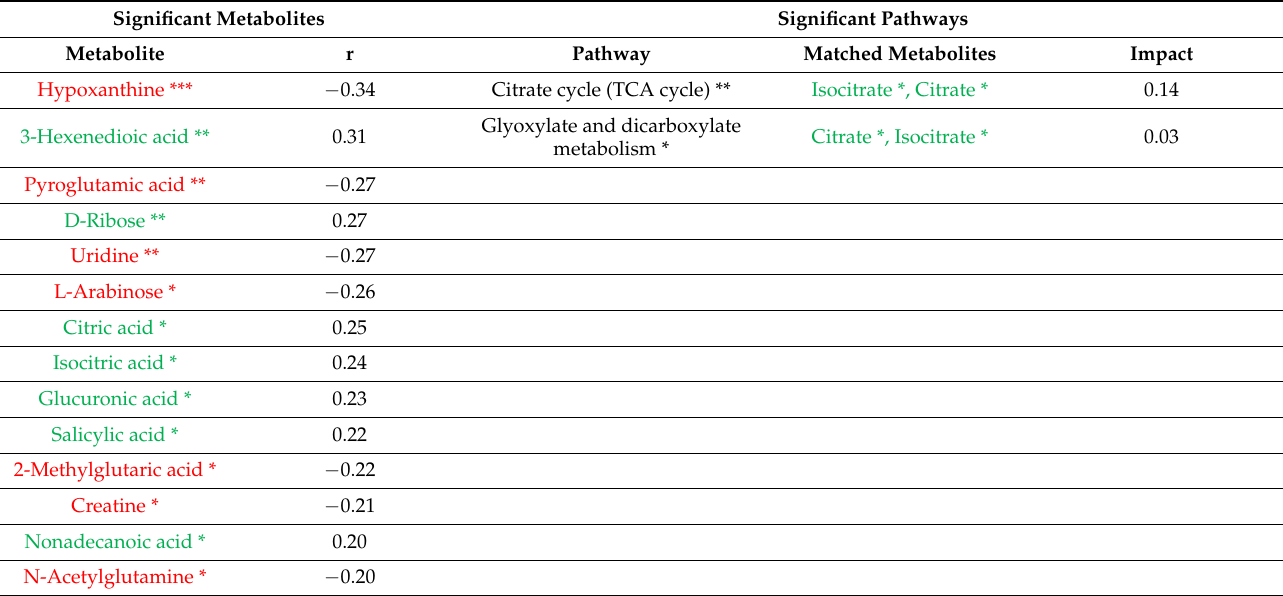
Figure 13. Metabolite-metabolite interaction network for significant metabolites that correlate to 3-chlorotyrosine, a biomarker of inflammation. Size of the node indicates importance in the network. The interaction analysis highlights the importance of the energy metabolism, particularly amino acid which feed into the citric acid cycle. Table 15. Metabolites and their pathways which correlate with a marker of inflammation. Table 16. Metabolites and their pathways which correlate with adenosine triphosphate linked